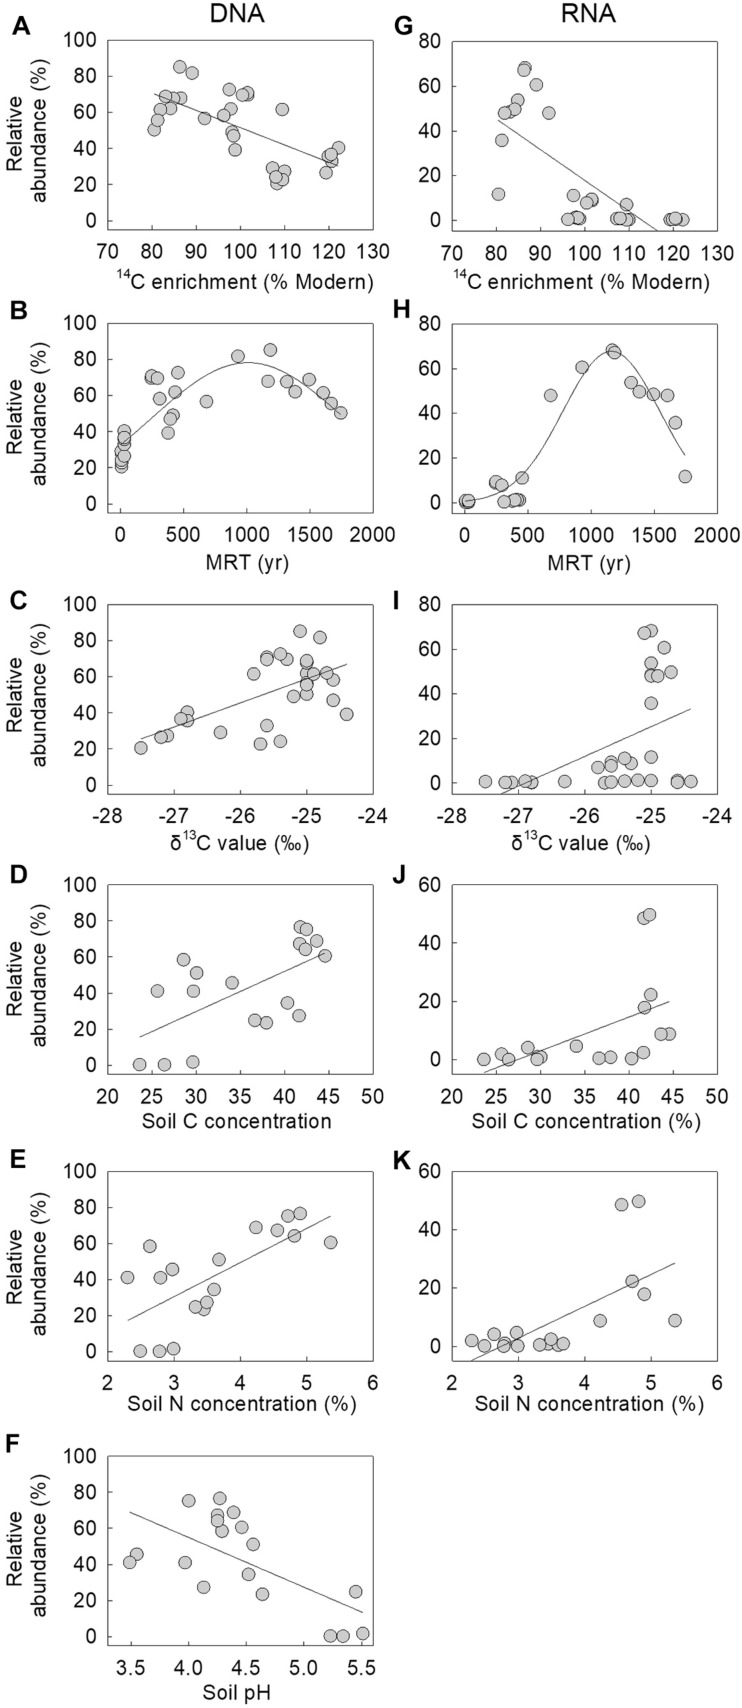
Relative abundances of the fungus in (A–F) DNA and (G–K) RNA communities as a function of soil 14C enrichment, mean residence time (MRT), δ13C content, C and N concentrations and pH value. Lines are best fits, derived from linear and (B,H) three-parameter Gaussian functions. Note that one sample, assigned a MRT of 9 or 77 years, was excluded from (B) and (H), and that the association between the relative abundance of the fungus in the RNA community and soil pH value was not significant.